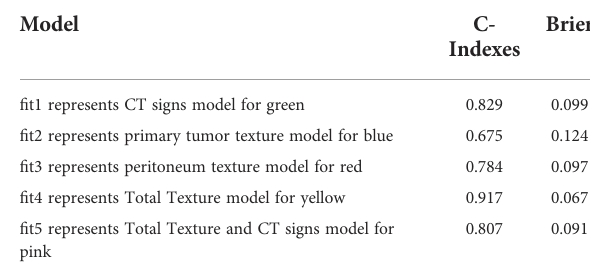
TABLE 6 Parameters of calibration curves of different prediction